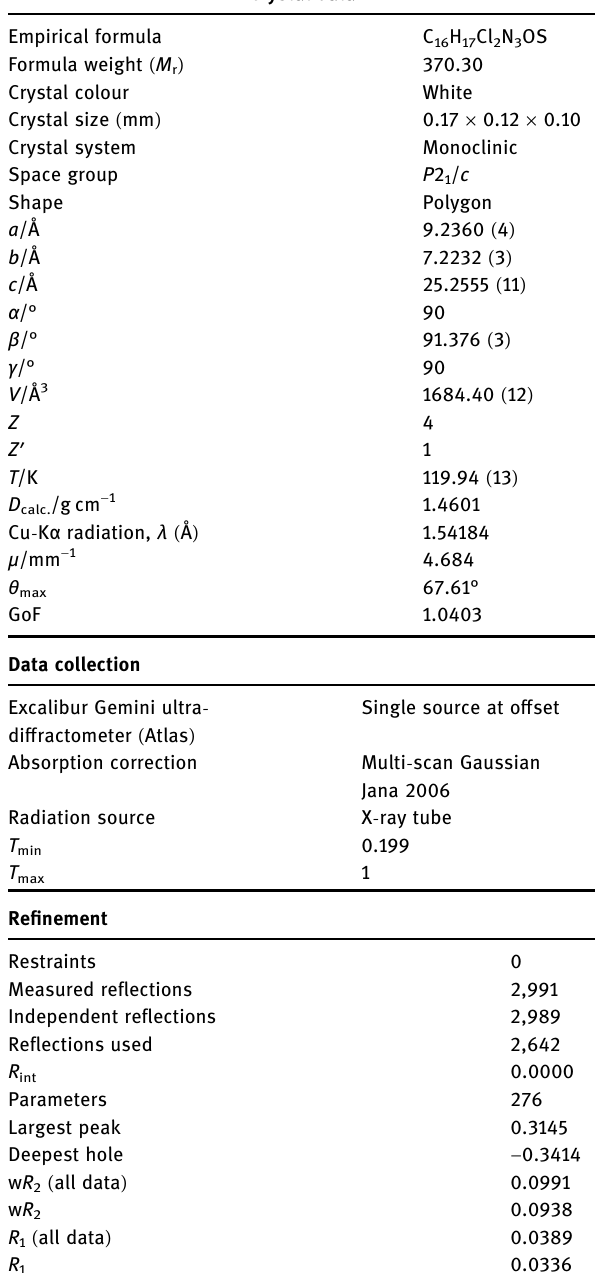
Table 1: Single - crystal X - ray di ff raction analysis of C 16 H 17 Cl 2 N 3 OS and its structural re fi nement